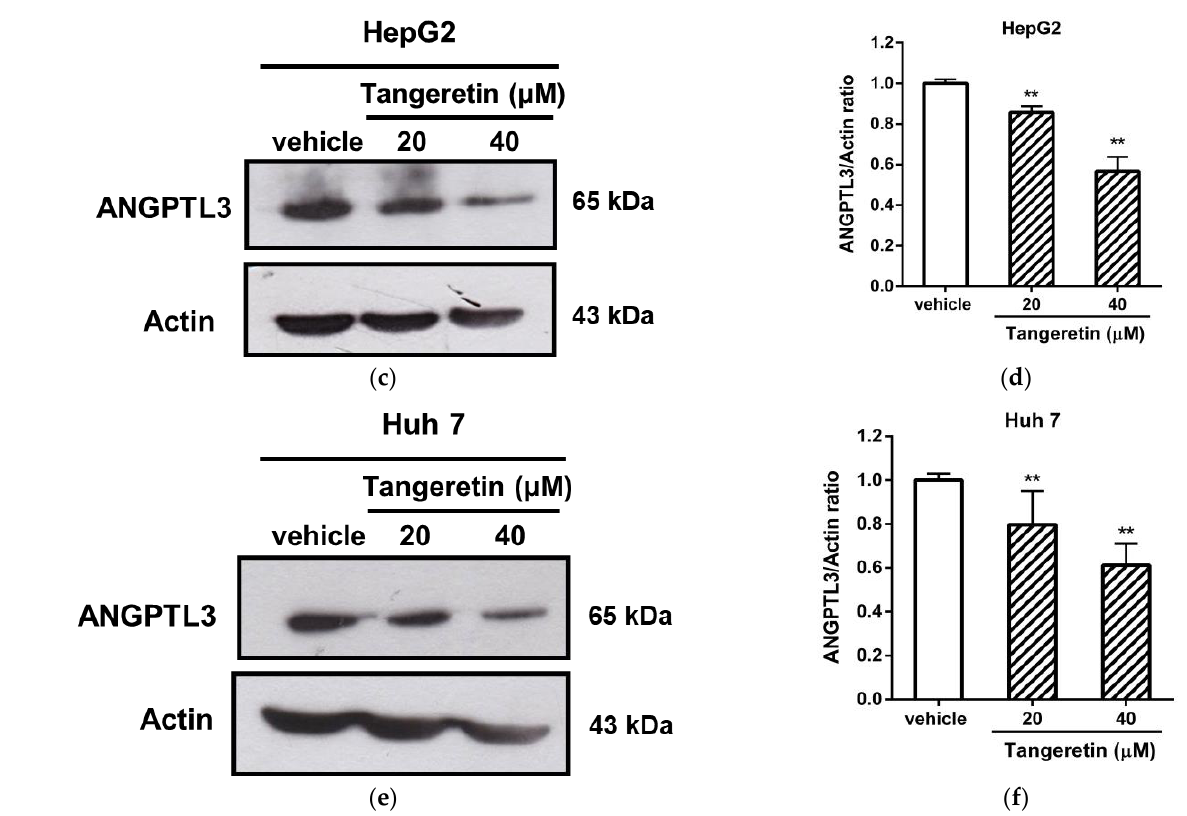
Figure 4. The effect of tangeretin on ANGPTL3 expression in HepG2 and Huh-7 cells. HepG2 and Huh-7 cells were treated with vehicle (0.1% DMSO) or tangeretin (20 and 40 μM) for 24 h. The mRNA expression of ANGPTL3 in ( a ) HepG2 and ( b ) Huh-7 cells was measured by RT-Q-PCR analysis. The data represent the mean ± SD of three independent experiments. The ANGPTL3 proteins in HepG2 and Huh-7 cells were determined by Western blot analysis. ( c , e ) Representative blots are shown. ( d , f ) The normalized intensity of ANGPTL3 versus actin protein is presented as the mean ± SD of three independent experiments. ** p < 0.01 indicates significant differences compared to the vehicle-treated cells.